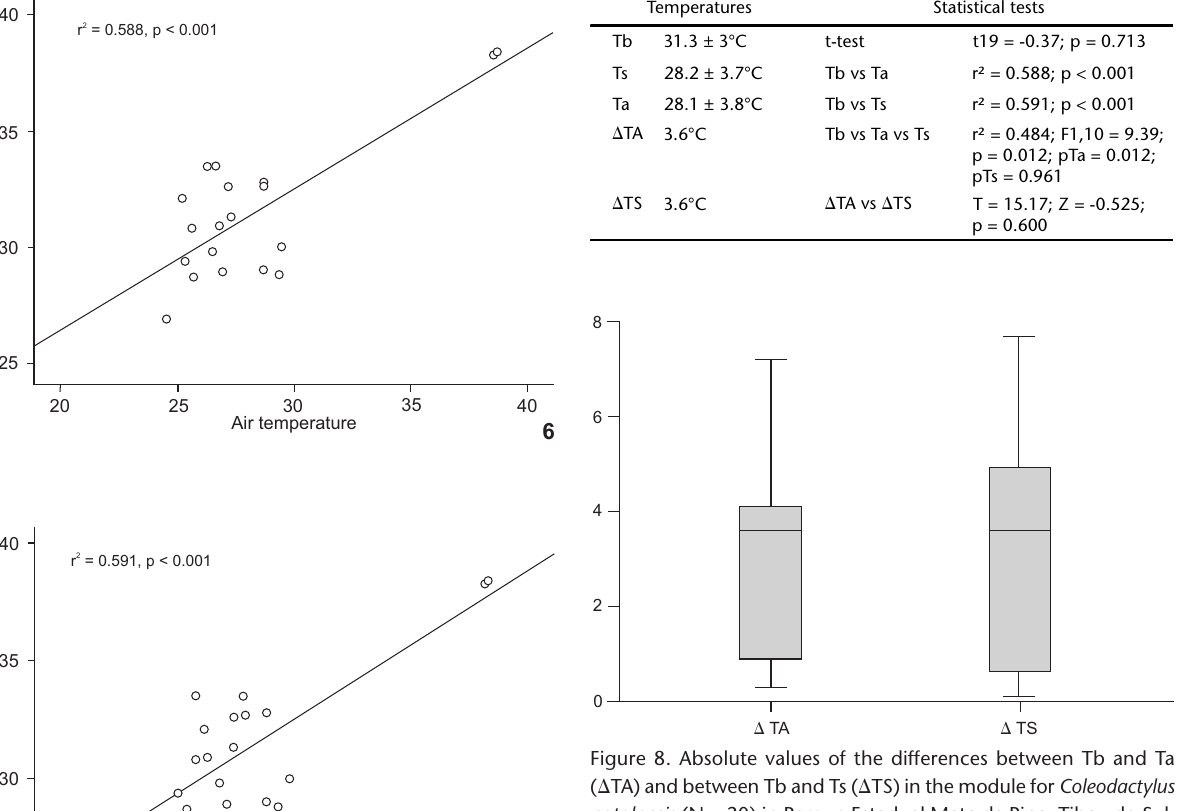
Table I. Mean body temperature (Tb) of active Coleodactylus natalensis (n = 20), mean air (Ta) and substrate (Ts) temperatures and median values of the module of differences between Tb and Ta ( (cid:2) Ta) and between Tb and Ts ( (cid:2) Ts) recorded in the lizard microhabitats, including a summary of paired t-test and simple and multiple linear regressions between the temperatures, as well as the paired Wilcoxon test between (cid:2) TA and (cid:2) TS. Temperatures